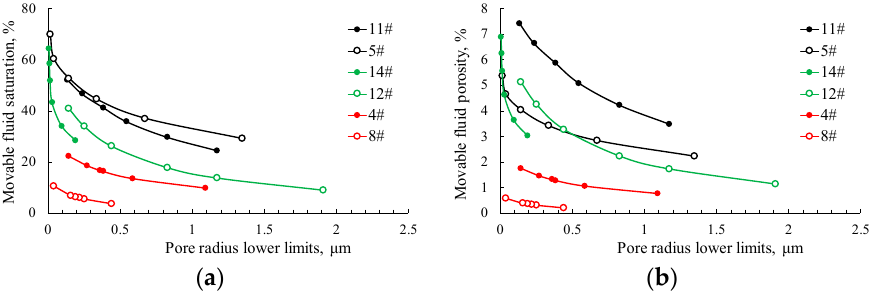
Figure 17. The plot of pore radius lower limits versus ( a ) movable fluid saturation and ( b ) movable fluid porosity.